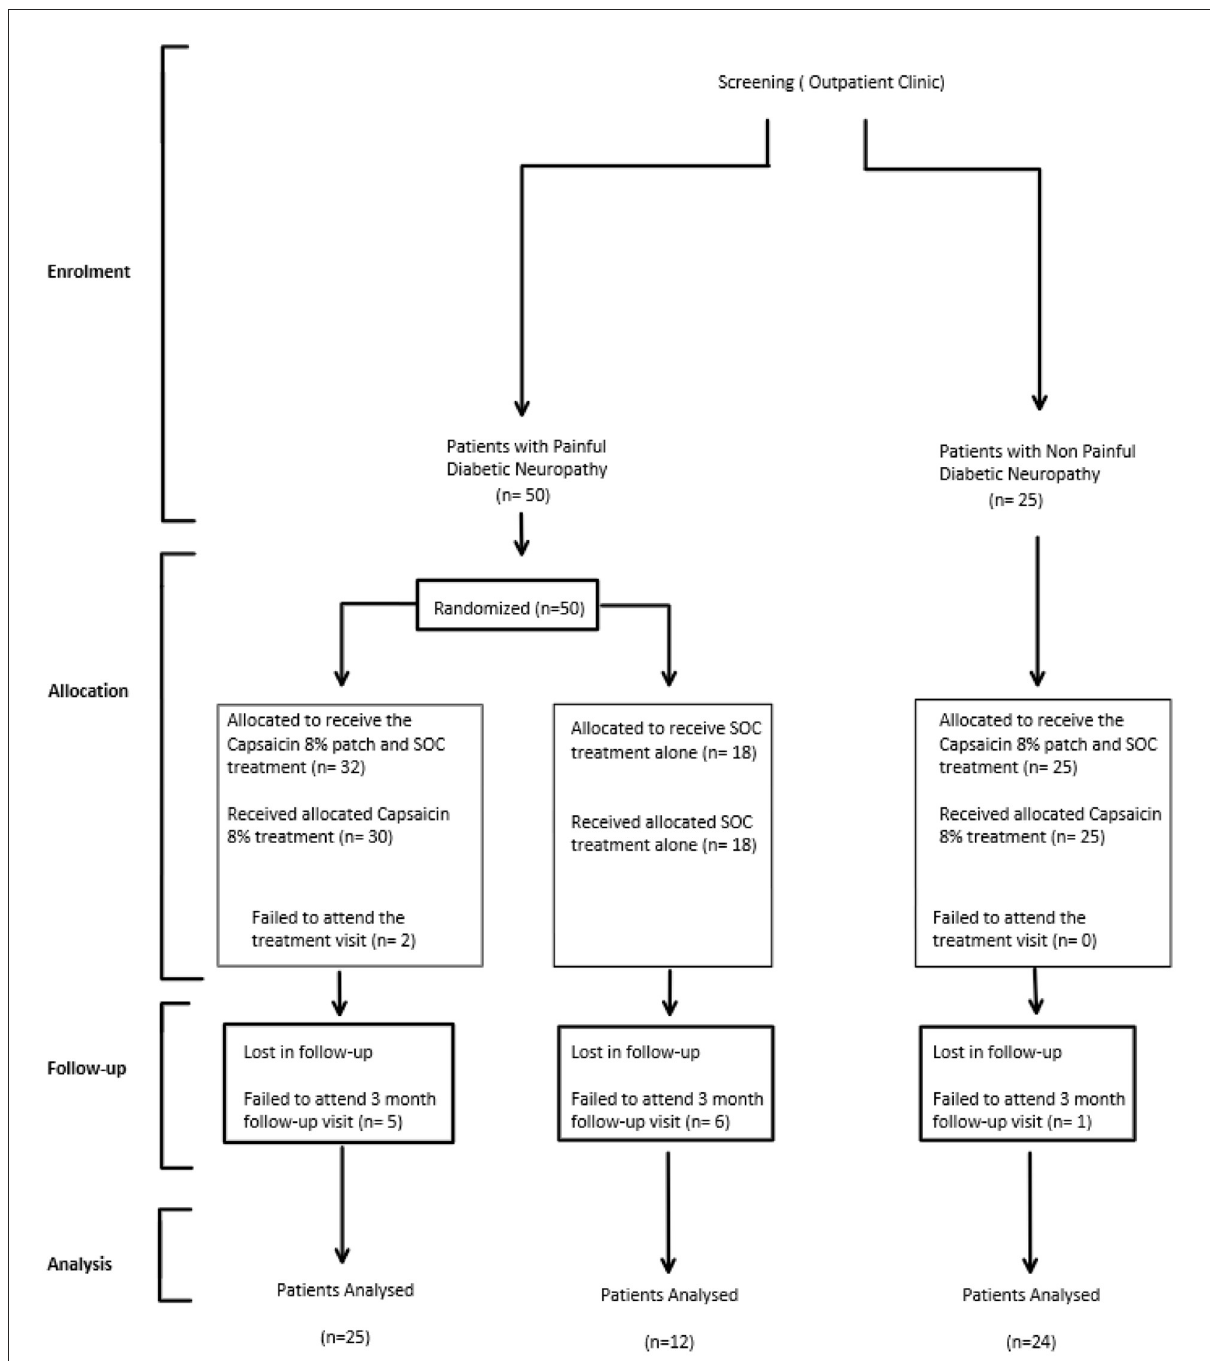
FIGURE1 Participant flow diagram for DPN Capsaicin 8% patch